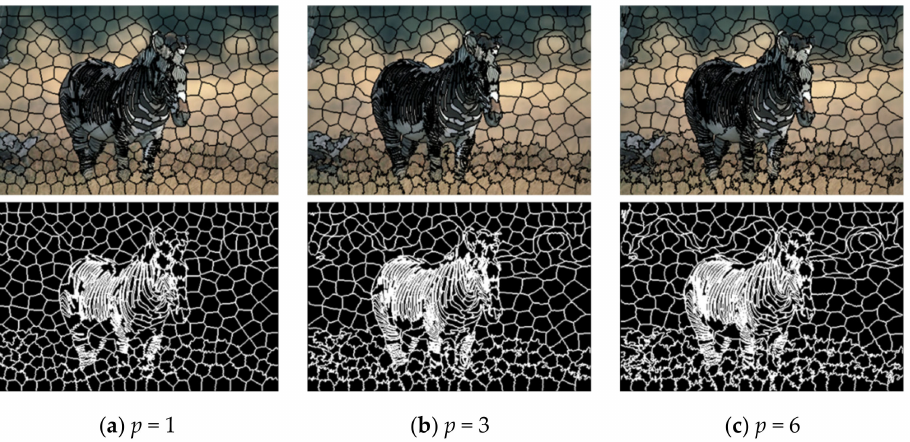
Figure 4. Superpixel segmentation results with di ff erent p values.